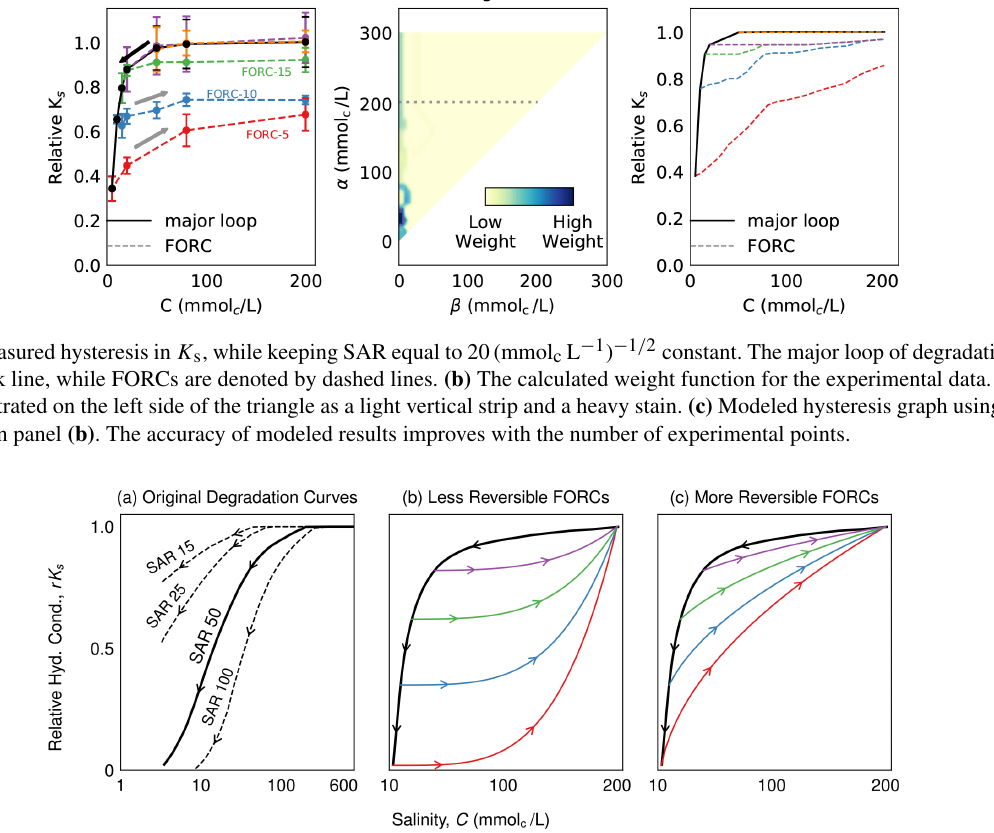
Figure 5. Different levels of irreversibility can be possible from the same degradation curve. (a) Degradation curves from experiments performed by McNeal and Coleman (1966). Note: results are presented on the logarithmic scale. The degradation curve associated with SAR 50 is used to construct two sets of possible FORCs, with one showing a low level of reversibility (b) and the other a high level of reversibility (c)